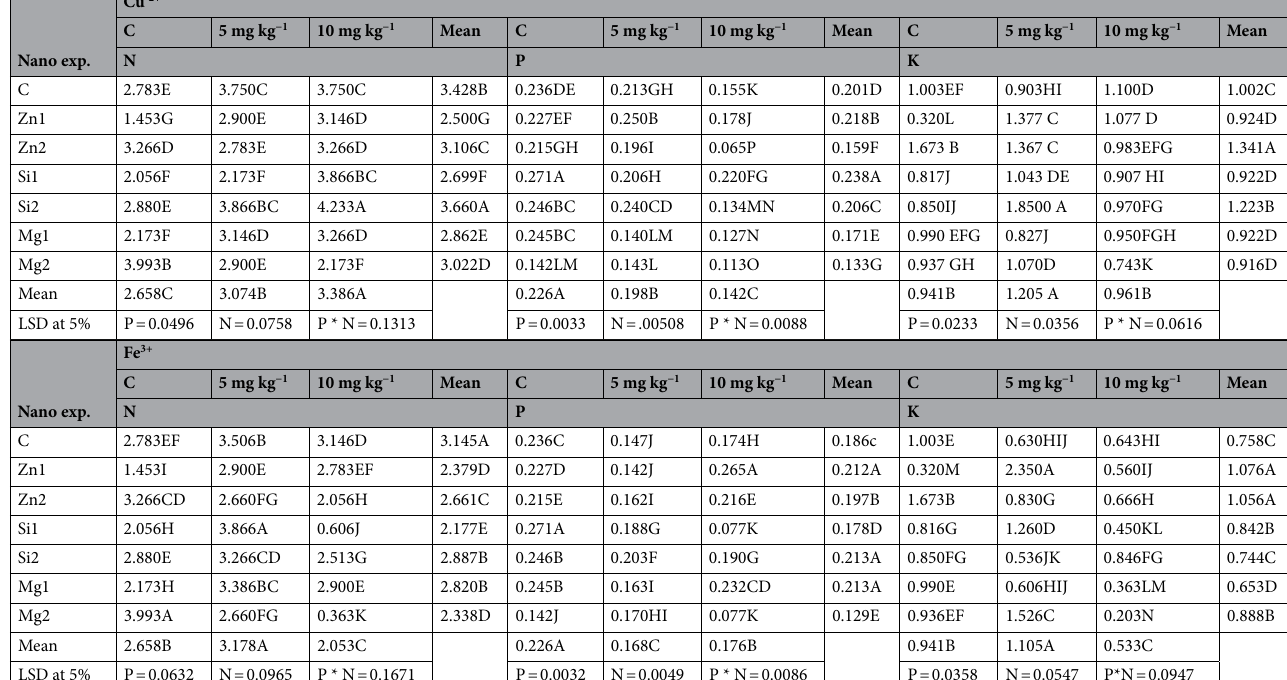
Table 6. Effect of polluted water containing Cu 2+ and Fe 3+ and different NPs on the availability and accumulation of N, P, and K in